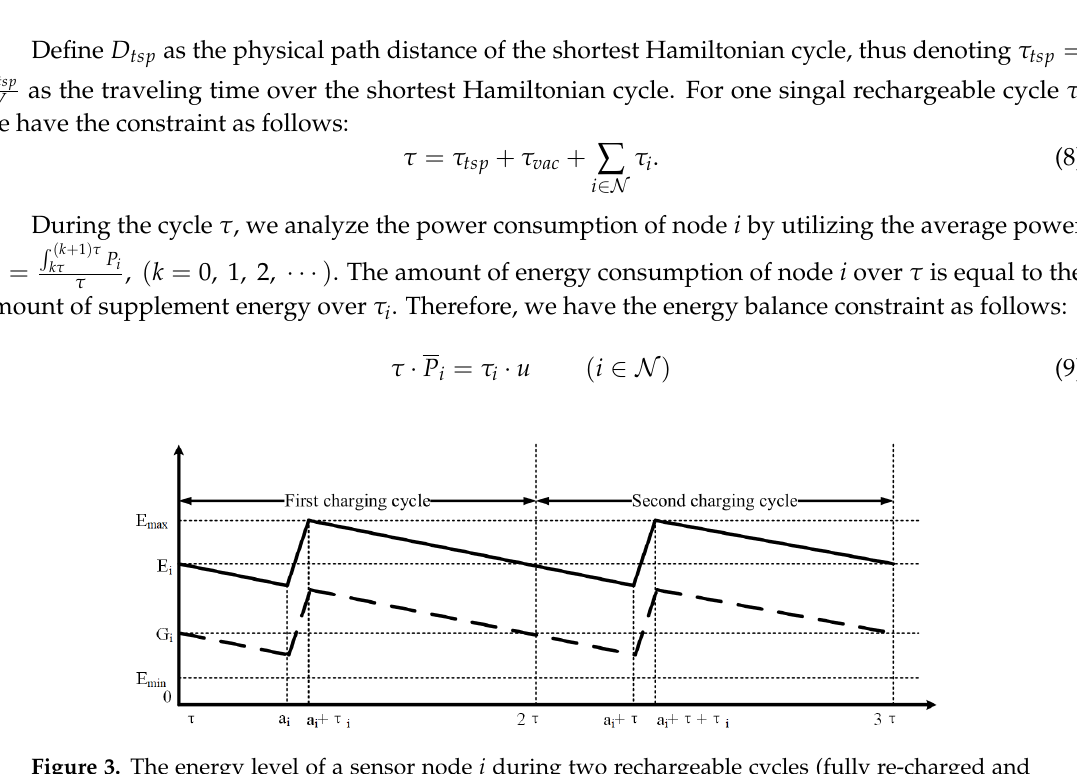
Figure 3. The energy level of a sensor node i during two rechargeable cycles (fully re-charged and partially